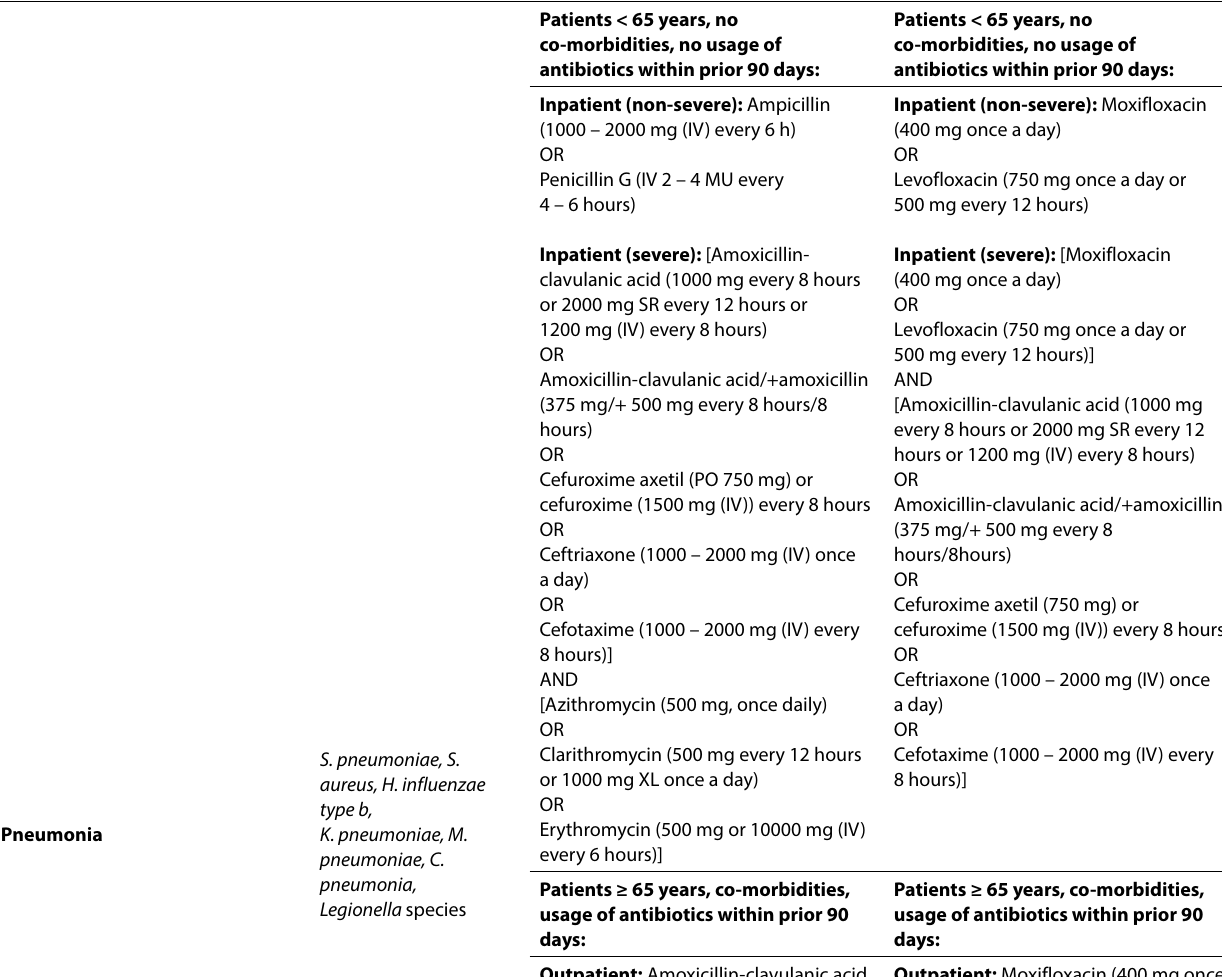
Table I. Main antibiotic treatment options for Upper and Lower Respiratory Tract Infections of bacterial origin (CONT.). 1,2-8,10,12-19,21,23,25-27